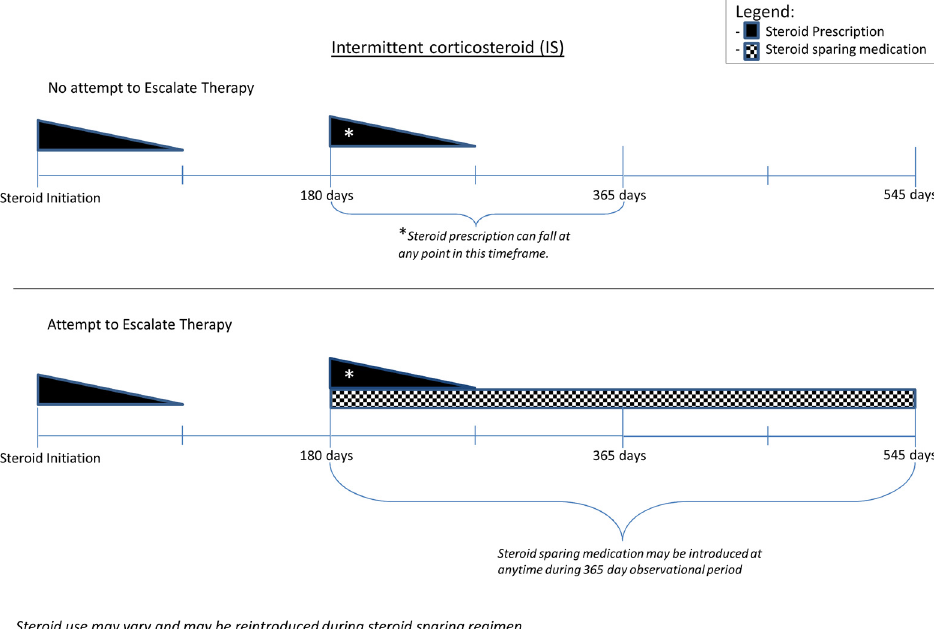
Fig 2. Escalation to corticosteroid-sparing therapy for Veterans who were intermittent corticosteroid users (IS).